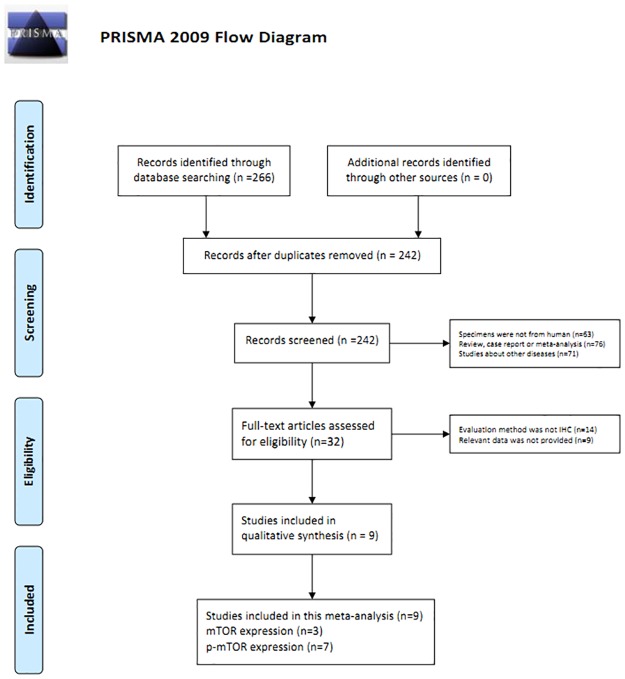
Flow diagram of study selection procedure.